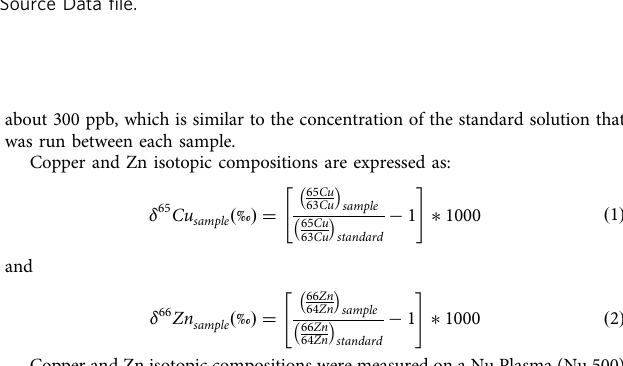
standards and duplicate analyses, the 2 standard deviations (2 SD) analytical uncertainty adopted in this study for both trace and major concentrations are on average better than 10% (Tables S1 and S2).